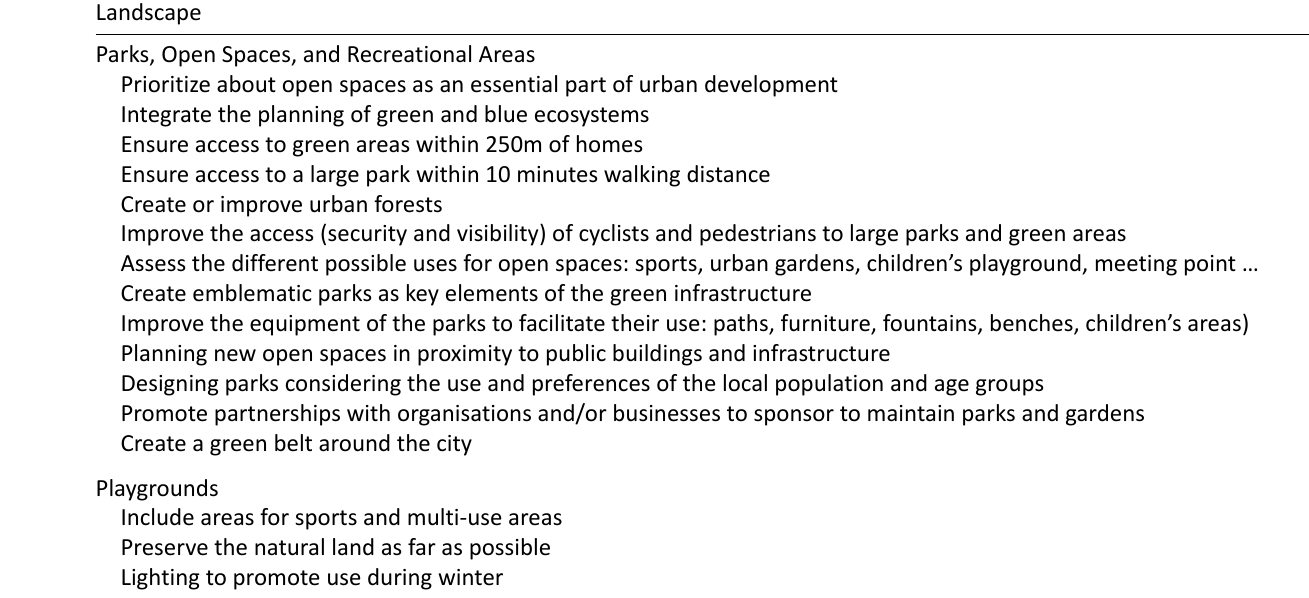
Table 1. (Cont.) The healthy urban planning action checklist for urban